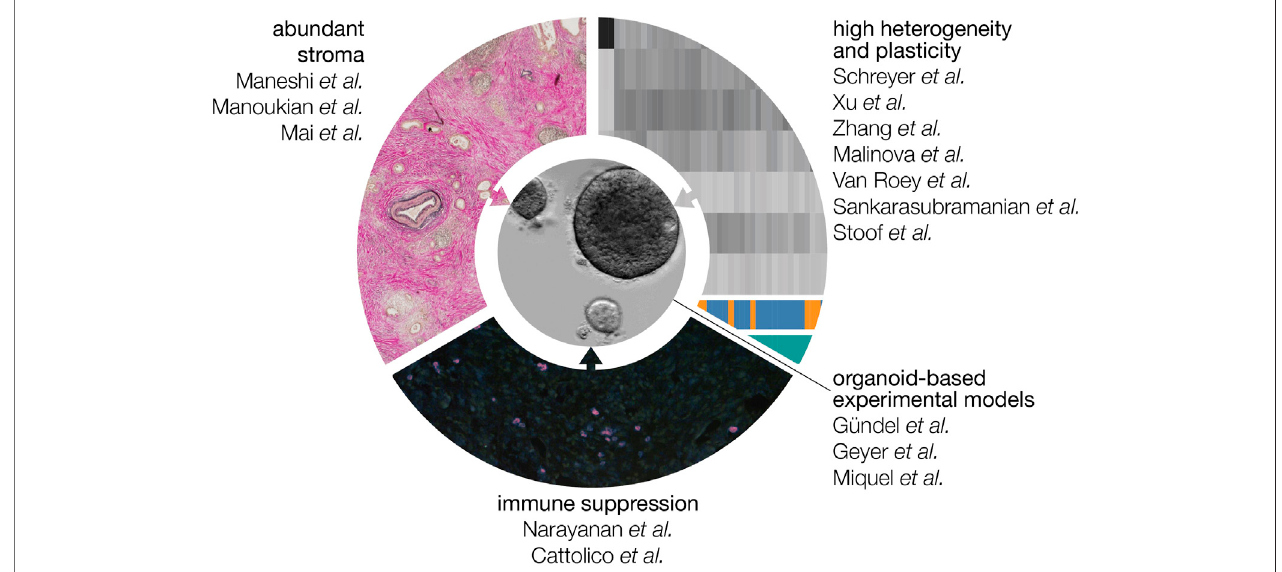
FIGURE 1 | Features that contribute to the poor prognosis of PDAC. The abundant stroma, high degree of heterogeneity at the level of gene expression, and immunesuppressive microenvironment allcontributetoatumor type thatquicklyprogresses toan incurable stageand isresistant tocurrently available regimens. Inthis Frontiers topic, the contributors explain how the organoid culturing system can be used and modi fi ed to address these tumor-promoting features experimentally.